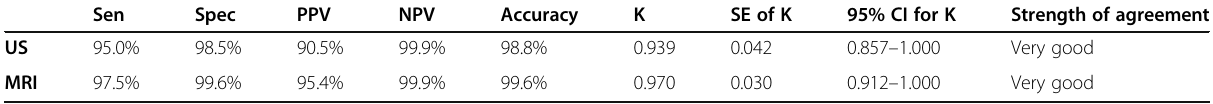
Table 3 Comparison of the diagnostic performance as well as agreement between MRI and US Sen Spec PPV NPV Accuracy K SE of K 95% CI for K Strength of agreement US